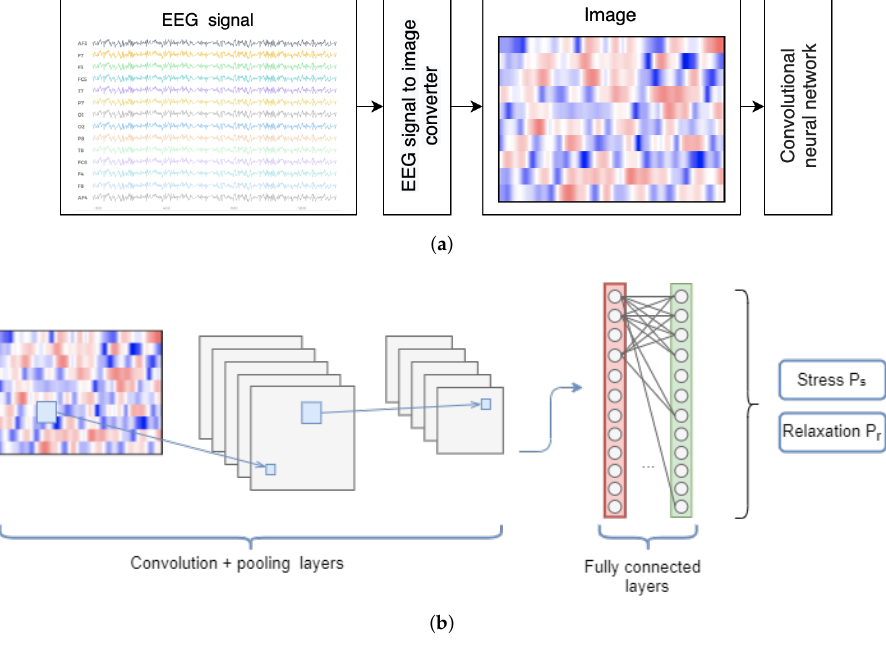
Figure 10. The process of using a CNN for EEG-based stress recognition ( a ) shows the process of making the heat-map image based on EEG signals, and ( b ) the structure of the CNN classifier, which uses the heat-map images as its